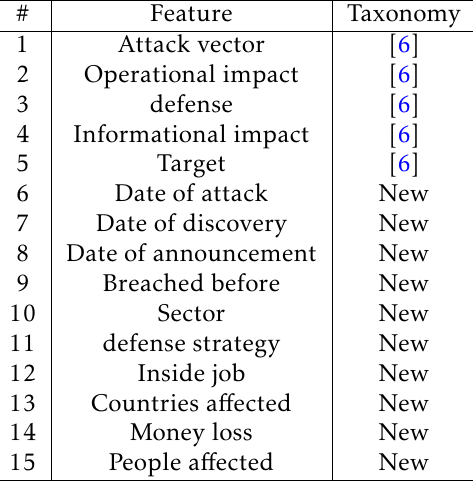
Table 2. The list of all features that we included in our